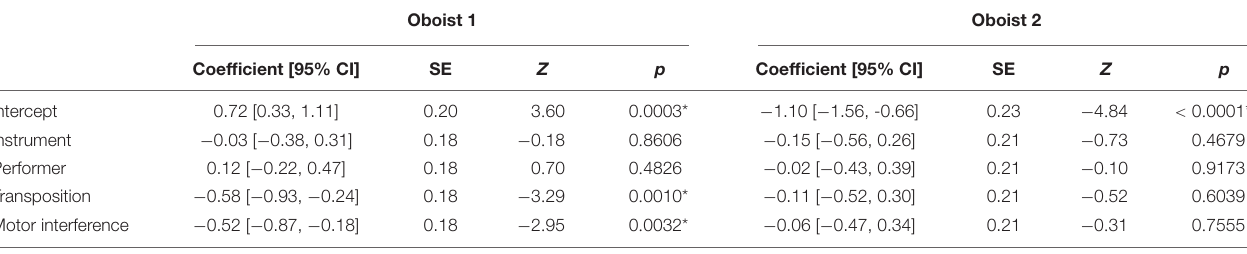
TABLE 2 | Main results from logistic regression of accuracy on the four condition variables: instrument (own oboe vs. other oboe), performer (self vs. other), transposition (original vs. pitch-shifted), and motor interference (no interference vs. motor interference), separately for Oboist 1 and Oboist 2.